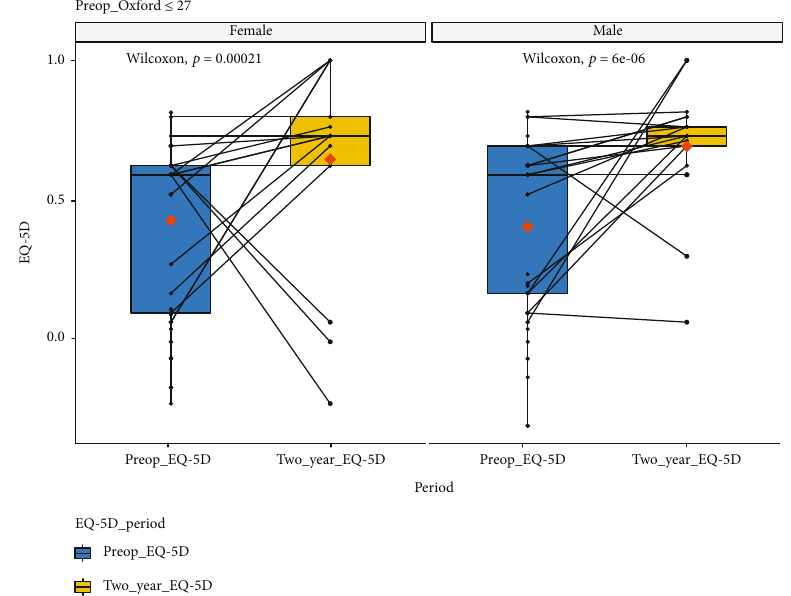
Figure 4: EQ-5D scores at baseline and 2-year follow-up for all those with OKS ≤ 27 . Male and female data has been plotted separately. x -axis: EQ-5D for the quality-of-life score at preoperative baseline and at two-year follow-up. y -axis: EQ-5D for the quality-of-life score value; boxplot showing L -estimators: outliers plotted as individual points at 2-year follow-up. Full data tabulated in Table 3. Connecting lines: heuristic visualization of single-patient trajectories of variation of EQ-5D for the quality-of-life score value for function between preoperative baseline and two-year follow-up; plotted with R (version 4.0.0 or higher; libraries ggpubr and PairedData). Source: authors ’